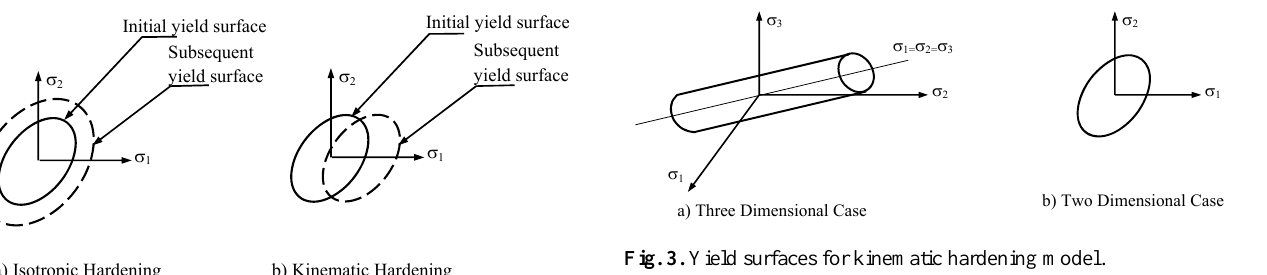
Fig. 3. Yield surfaces for kinematic hardening model.